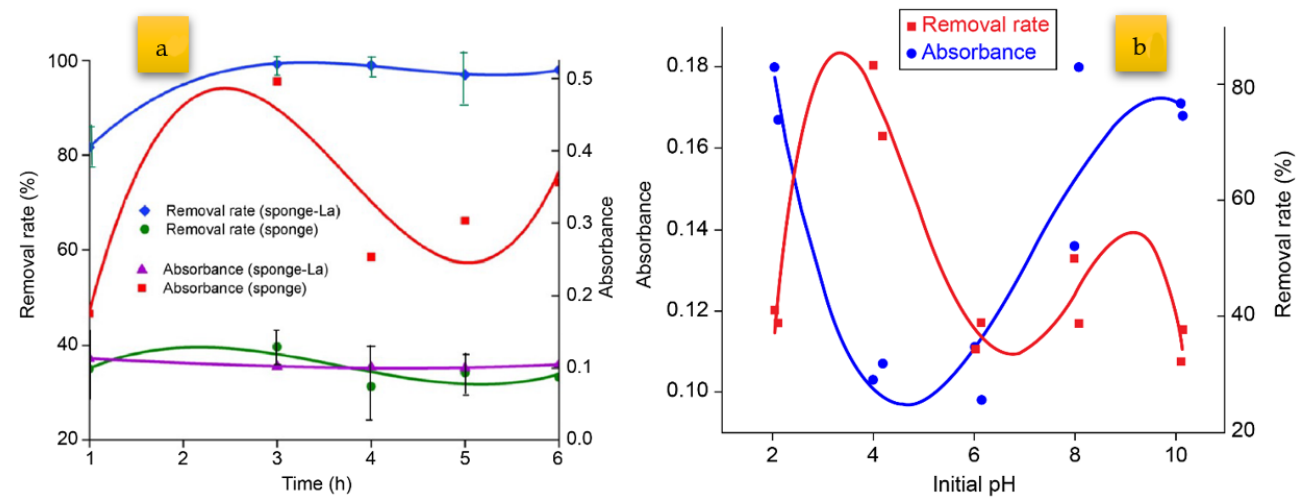
Figure 8. Inversely proportional relationship between absorbance and removal rate for sponge – La against different time intervals ( a ) and different pH ( b ).